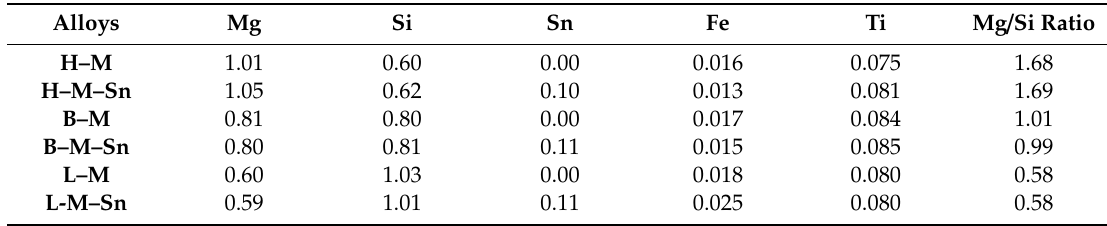
Table 1. Chemical composition of the investigated alloys (wt